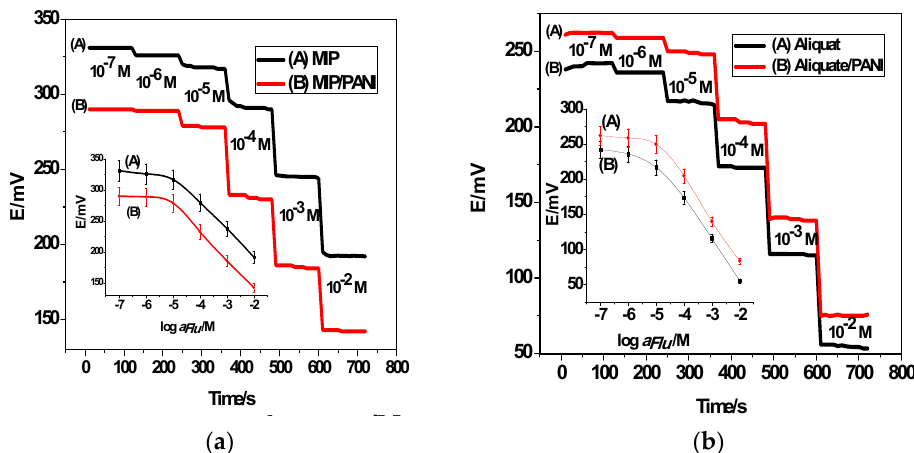
Figure 3. The time-dependent potential response curve of the proposed electrodes integrated with ( a ) MIP nanobeads curve and ( b ) aliquat. Table 1. Potentiometric characteristics of flucarbazone ion-selective electrodes (ISEs) in 30 mM phosphate bu ff er solution (PBS), pH